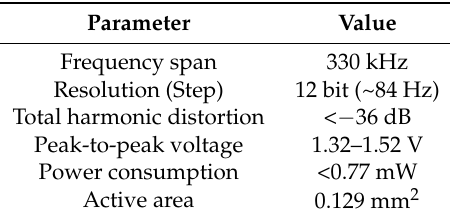
Figure 12. Output quadrature signals measurements: ( a ) Screenshot of the oscilloscope for the digital code #500; ( b ) Spectral analysis of the output signal for the digital code #500; and ( c ) Total harmonic distortion of the output quadrature signals. Table 2. Oscillator measured performances.